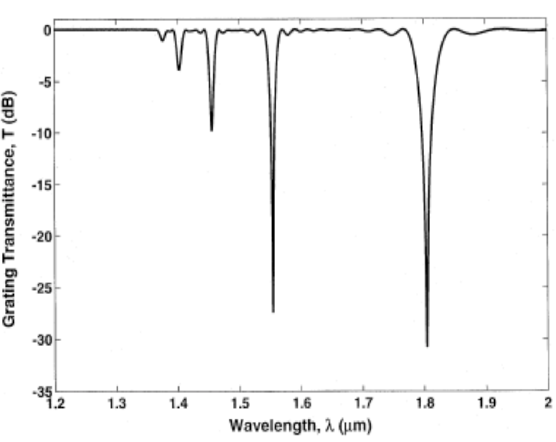
Figure 1. Representative LPFG transmission response.